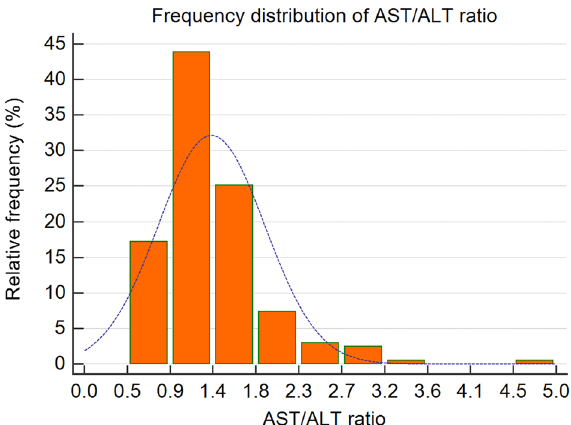
Figure 1. Distribution of aspartate amino transferase (AST)/alanine aminotransferase (ALT) ratio.